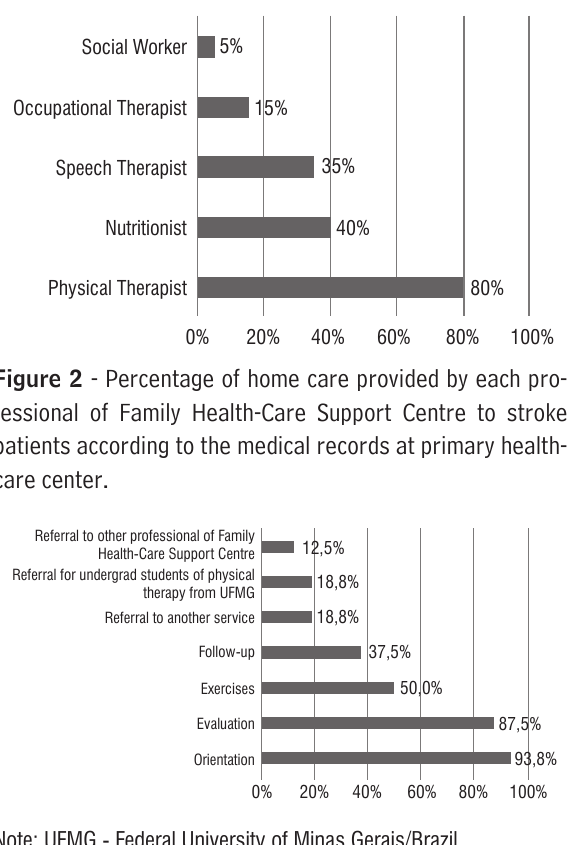
Figure 3 - Percentage of care sessions carried out by the physical therapist of Family Health-Care Support Centre to stroke patients according to the medical records at primary healthcare